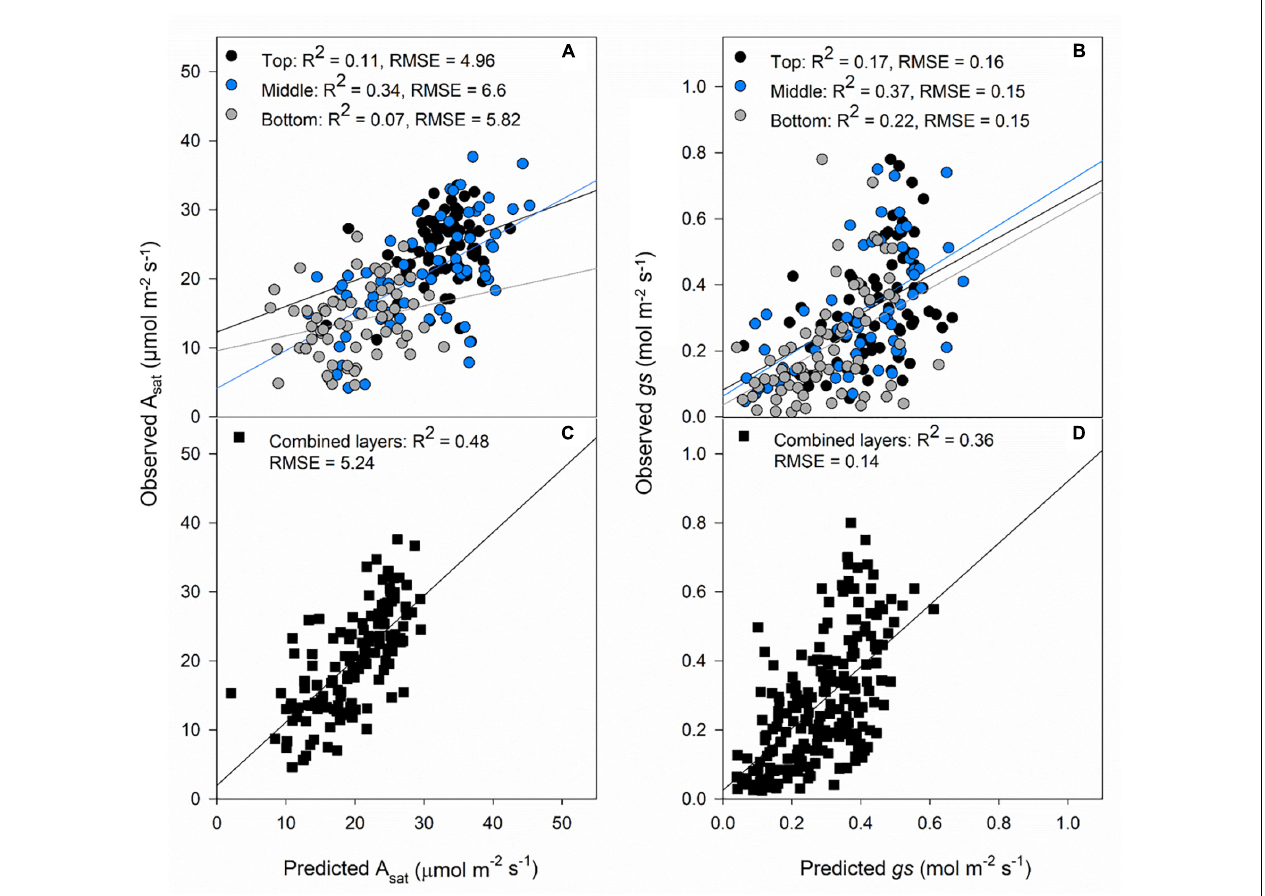
FIGURE 4 | Validation results of PLSR models predicting A sat (A) and gs (B) by separating each layer of the canopy (top panels) and predictions of A sat (C) and gs (D) combining all the layers of the canopy (black squares). Black dots: top of the canopy, blue dots: middle of the canopy, gray dots: bottom of the canopy. The lines represent the linear regression between predictions and ground truth